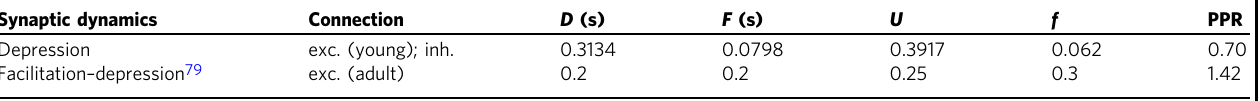
Table 4 STP parameter values used for the facilitation-depression STP model. Synaptic